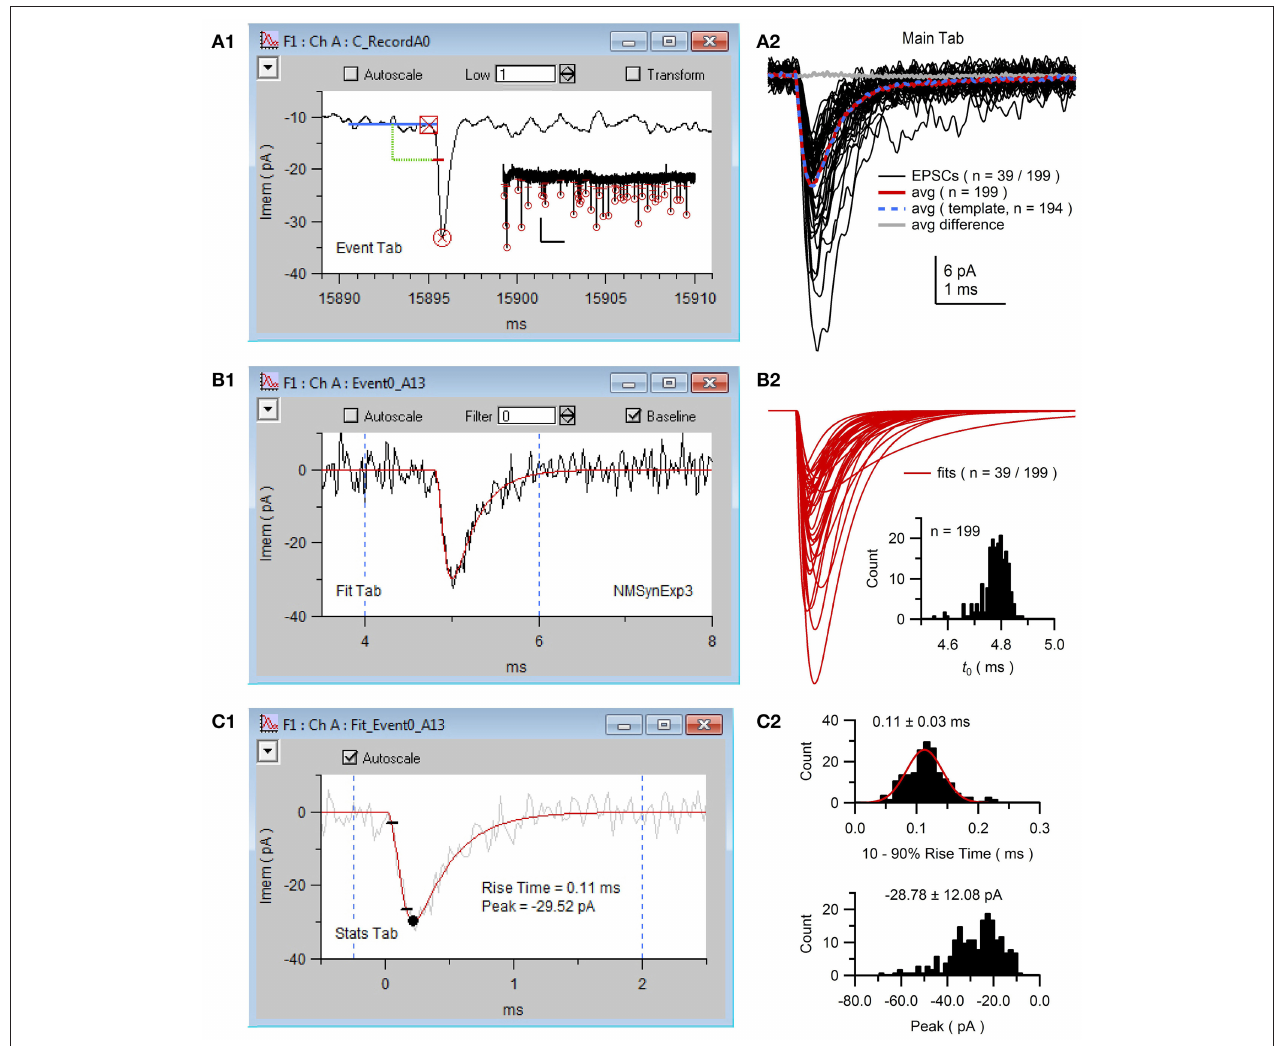
FIGURE 9 | NeuroMatic acquisition, detection and analysis of spontaneous EPSCs. Spontaneous EPSCs with isolated AMPA receptor (AMPAR) component were recorded from the cell body of a GC. The stimulus protocol called Minis was configured via the Clamp tab to perform continuous whole-cell voltage-clamp recordings with 50kHz sampling. (A1) Screen capture of the channel A graph during negative event threshold detection via the Event tab with criteria shown in Figure 8 . Blue line denotes the sliding baseline window (5ms). Green line denotes the negative threshold search criteria (2.5ms ahead of the center of the baseline window, 6pA below the baseline average). Red dash denotes the threshold crossing point of the detected EPSC. Red square and circle denote results of the EPSC onset and peak detection, respectively. Data (black line) was low-pass filtered at 1kHz during event detection. Inset , first 39 of 199 detected EPSCs (thresholds and peaks) of the 170-s recording; x- and y-scale bars, 5s and 20pA. (A2) Detected EPSCs ( n = 199) were copied to new waves (Event/Events 2 Waves) and selected for analysis via the wave-prefix select (“Event0_”). Black lines are the first 39 EPSCs overlaid (low-pass filtered at 5kHz for display purposes). EPSCs were aligned to their onset ( t 0 ), as described in (B2) . Red line is the average of all 199 aligned unfiltered EPSCs. Event detection was repeated using this average for template matching (average normalized to have a baseline of 0 and peak of 1, truncated to 3ms length with 0.2ms baseline; detection criteria level = − 3) resulting in 194 detected EPSCs whose average is plotted in blue. The difference between the two averages was near 0 (gray line). To run template matching, place NeuroMatic’s MatchTemplate XOP (see http://www.neuromatic.thinkrandom.com/NMInstall.html) inside Igor’s Extensions folder, activate “template matching” on the Event tab, select the template wave from the current data folder and click the Event tab’s Match button. Scale bars are for data here and (B2) . (B1) Screen capture of the channel A graph during the curve fit (red line) of the same EPSC in (A1) to the multi-exponential function NMSynExp3 (Equation 1; second decay component was set to zero) via the Fit tab. EPSCs were fit between 4 and 6ms (dashed blue lines), a window that contained the EPSC onset, peak and initial decay. Data was unfiltered during the fits. (B2) The first 39 of all 199 fits to the detected EPSCs. Fits were selected for analysis (wave prefix “Fit_Event0_”) and aligned on their onset (GUI/Main/X-scale/Align/align by a wave of values/FT_Syn3_X0_EV0All_A0). Inset , histogram of the onset ( t 0 ; see Equation 1) of all 199 fits (0.01ms bins). (C1) Screen capture of the channel A graph during Stats 10–90% rise-time analysis of the curve fit in (B1) (red line). Black circle denotes the minimum peak value and small black lines denote times when the fit reached 10 and 90% of the peak value. Dashed blue lines denote window for minimum peak detection. The EPSC in (B1) was added to the background for display purposes (gray line). (C2) Histogram of 10–90% rise times (top; 0.01ms bins; 2 EPSCs with slow rise times 0.5–0.7ms are not shown) and minimum peaks (bottom; 2pA bins) for the 199 fits computed via the Stats tab (Stats2/Functions/Histogram). The rise-time histogram was fit to a Gaussian function (red line; peak center at 0.11ms, STDV = 0.03ms; Menu/Analysis/Curve Fitting.../gauss). GC experimental details: cerebellar slice from a P25 rat, R a = 15.5 M (cid:127) , C mem = 2.6 pF, V hold = − 80mV. The external solution contained 10mM MNI-glutamate. Data is from DiGregorio et al. (2007).